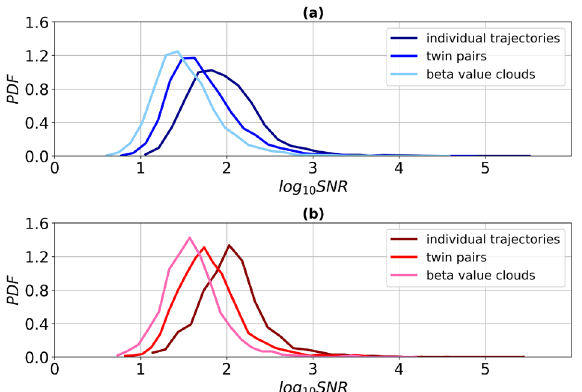
Figure 3. The probability density function (PDF) for log 10 SNR of aVMPs. Top panel ( a ) - for males (dark blue - individual trajectories, blue - twin pairs, light blue - clouds of beta values), bottom panel ( b ) - for females (dark red - individual trajectories, red - twin pairs, pink - clouds of beta values).